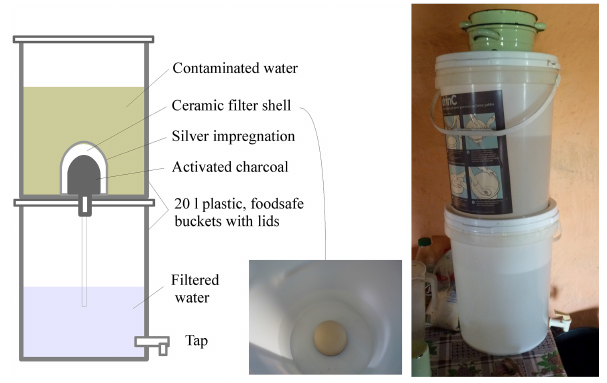
Figure 2. Technical layout of the tested